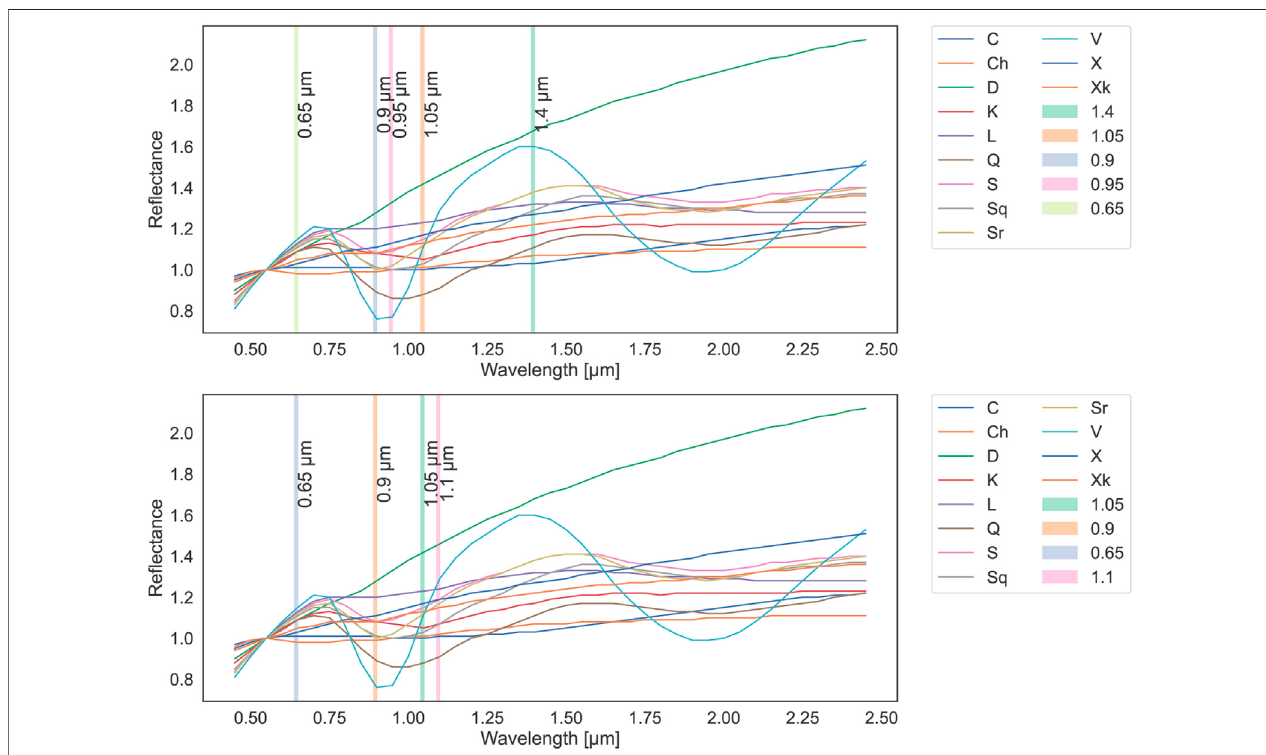
FIGURE 4 | Most important spectral features in the task of taxonomic types (top) and complexes (bottom) prediction against mean re fl ectance values of taxonomic types used in classi fi cation, as measured with balanced accuracy.